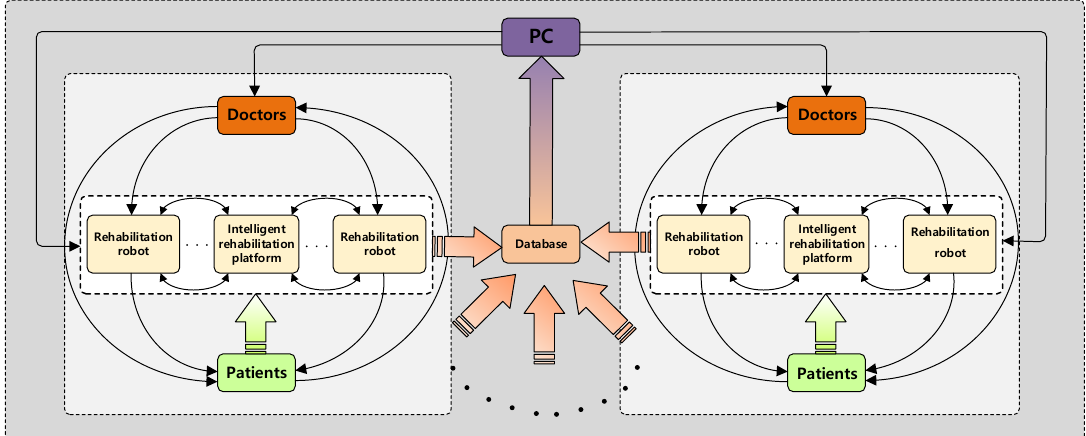
Figure 10. Multi-dimensional intelligent rehabilitation system.